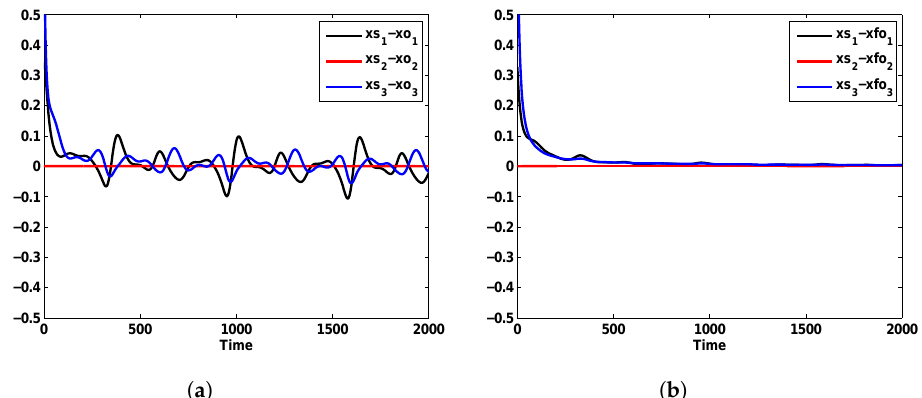
Figure 4. State estimation error in free of fault case. ( a ) State estimation error between the FOTS system and FUIO in a free of fault case. ( b ) State estimation error between the FOTS system and FOUIO in a free of fault case.